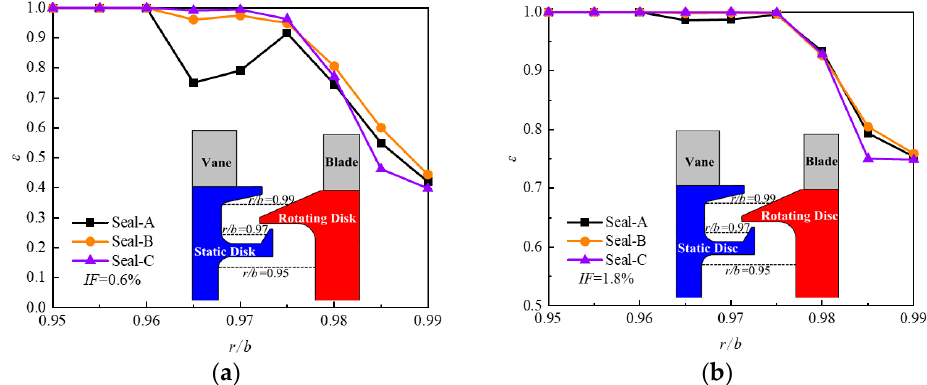
Figure 25. Sealing efficiency distribution along the radial direction in the disk cavity: ( a ) IF = 0.6%; and ( b ) IF = 1.8%.